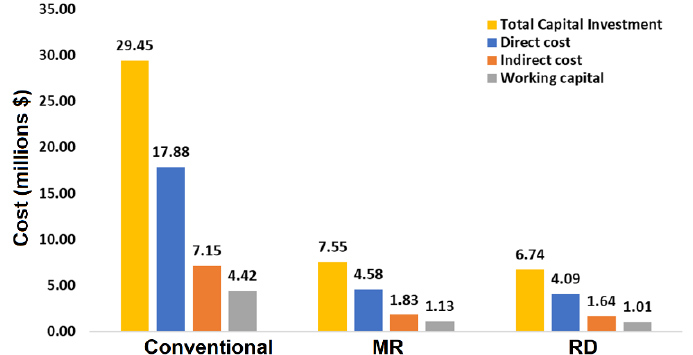
Figure 19. Economic comparisons of the three processes for n -butanol esterification with acetic acid.